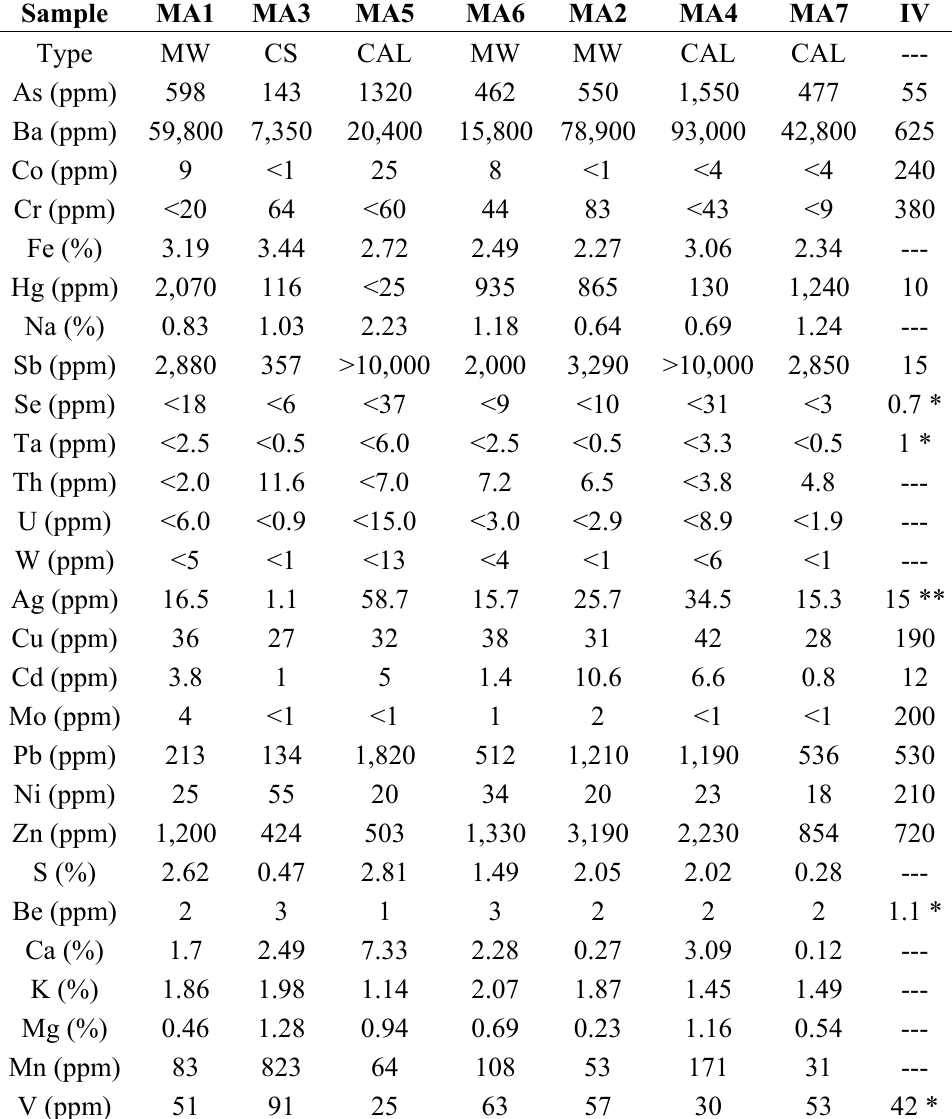
Table 1. Metal concentration in soils and mine wastes. Values in parts per million, except Fe (%), Na (%), S (%), Ca (%), K (%) and Mg (%). MW, mining wastes; CS, contaminated soil; CAL, calcine; IV, intervention values for soil remediation of the Dutch regulations